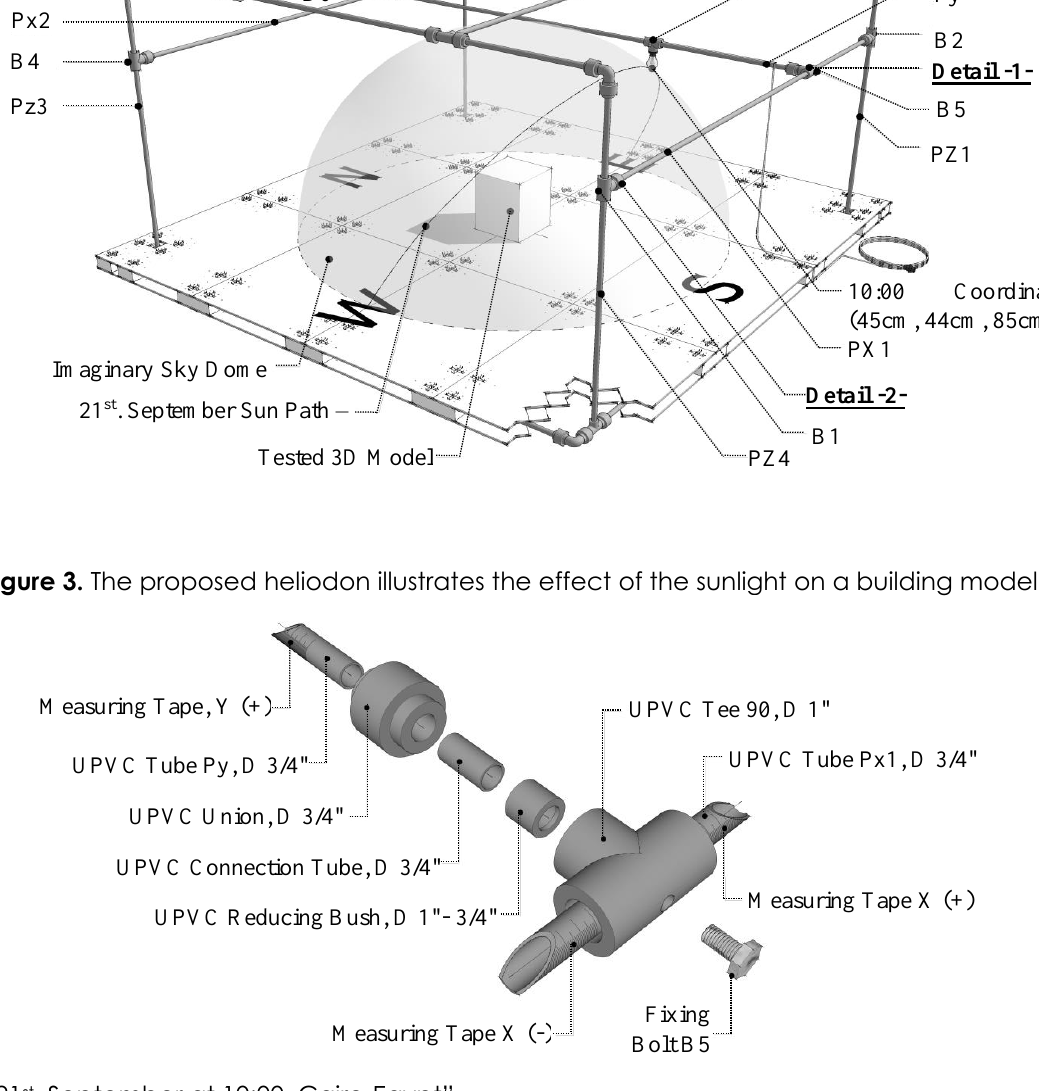
Figure 4. Detail